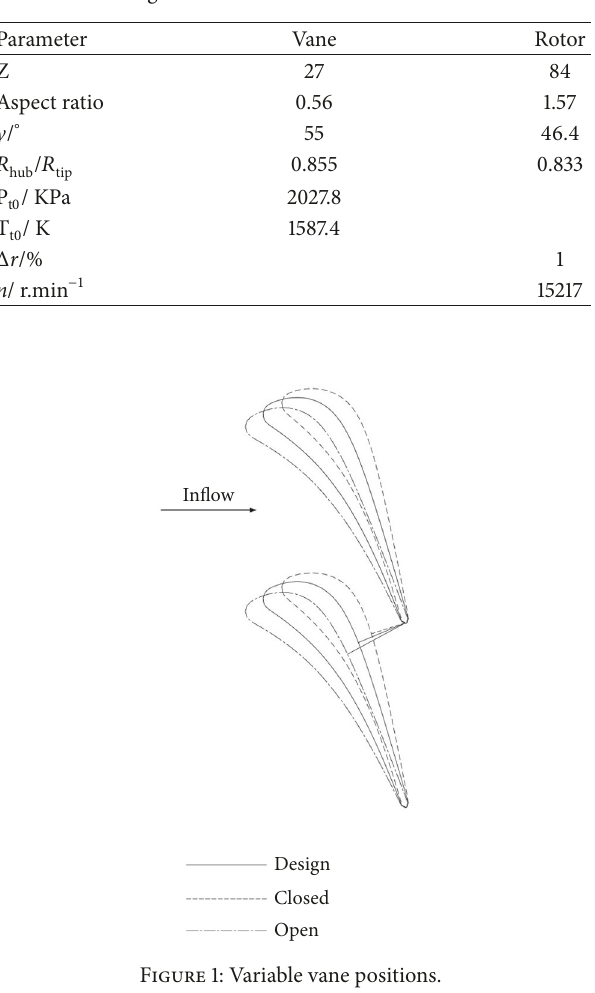
Table 1: Design characteristics of the vane and rotor blade.